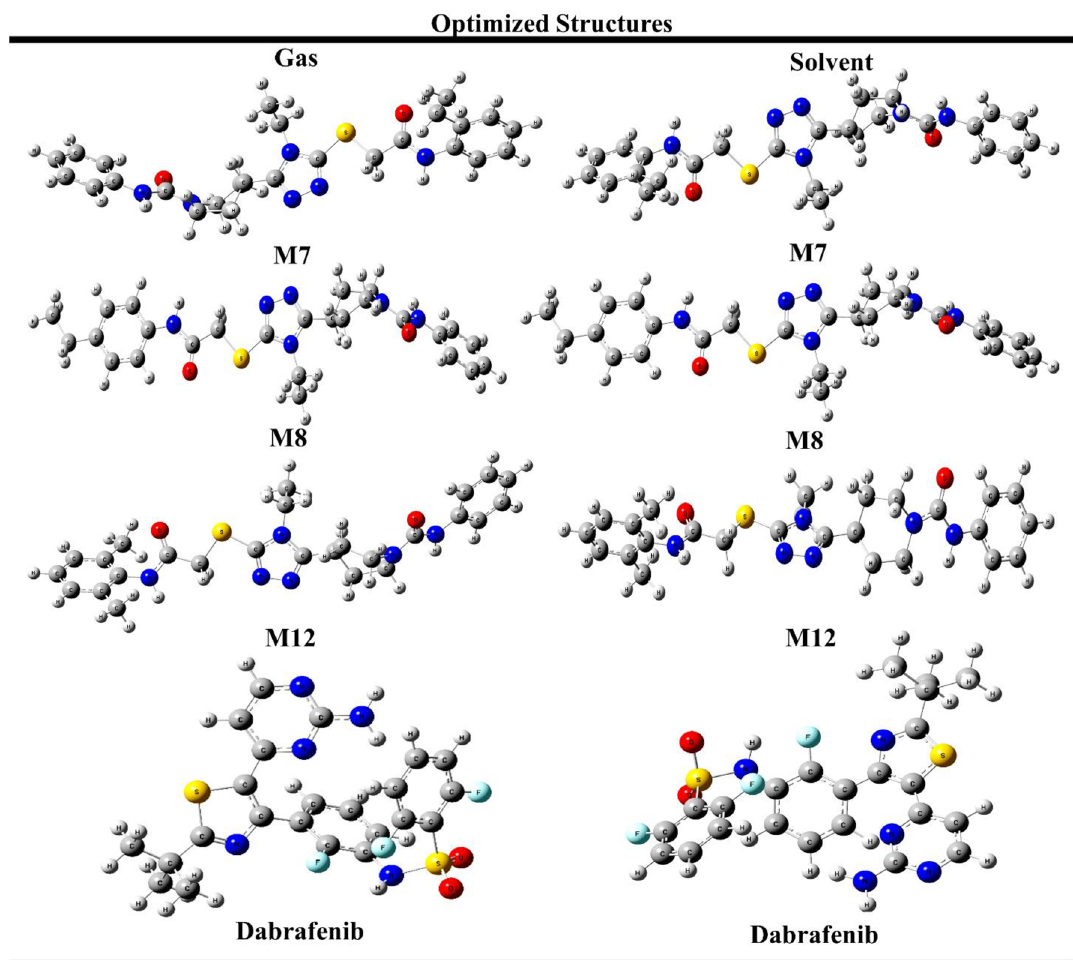
Figure 3. Optimized structure of potent compounds along with standard using B3LYP/SVP level of